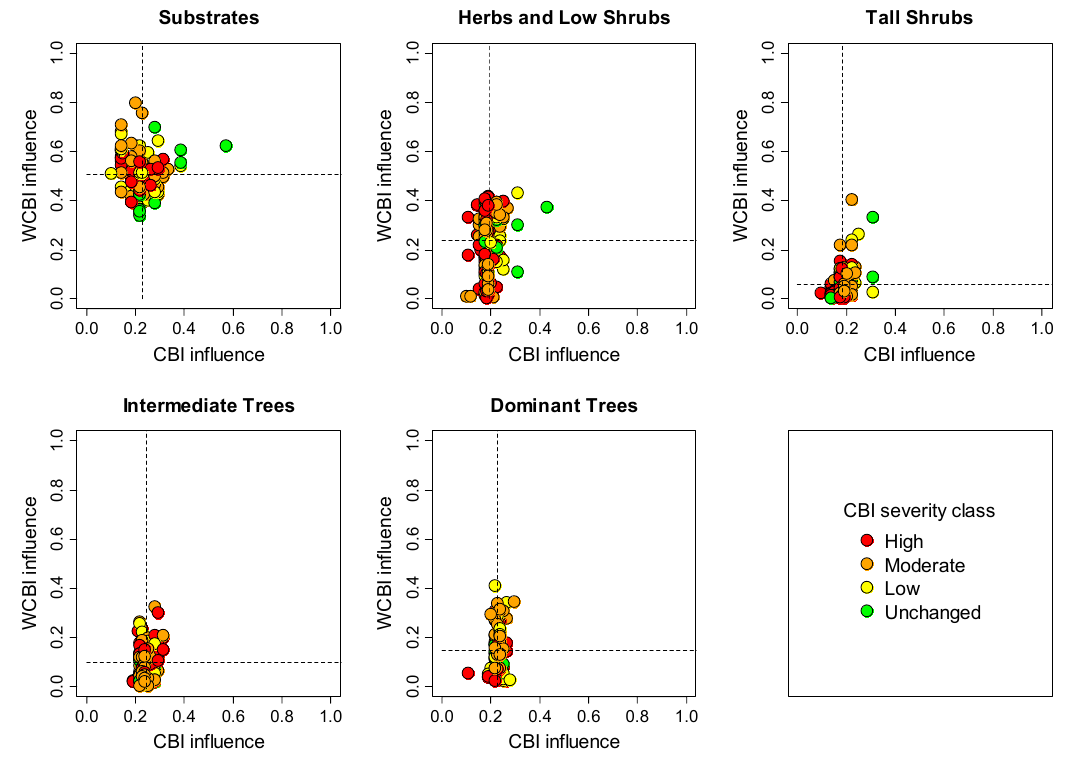
Figure 6. The influence of each stratum’s WCBI score on the total plot WCBI score plotted against the influence of CBI score on the total plot CBI score. Strata that were not assessed ( i.e. , 0% cover) were excluded from this analysis. Dashed lines represent the mean CBI and WCBI influence. Comparison of the dashed lines shows that use of WCBI increased the influence of the substrates and herbs and low shrubs strata, and decreased the influence of tall shrubs, intermediate trees, and dominant trees. Herbs and Low